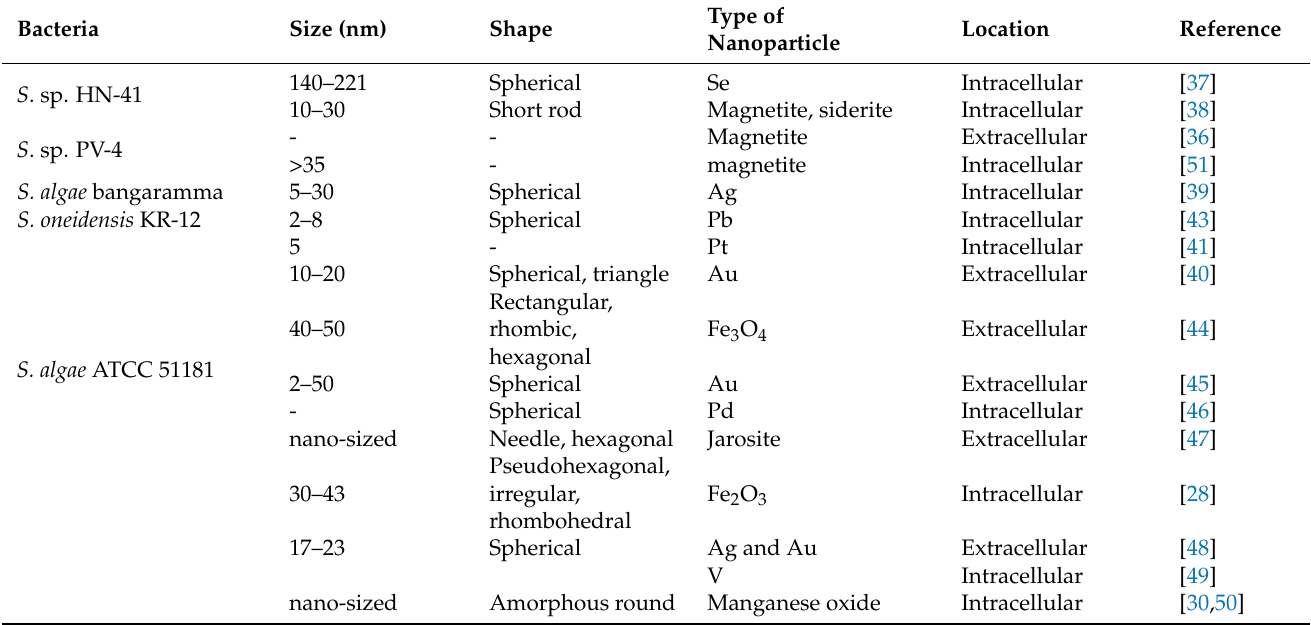
Table 1. The summary of biological nanoparticle synthesizing from the genus Shewanella .